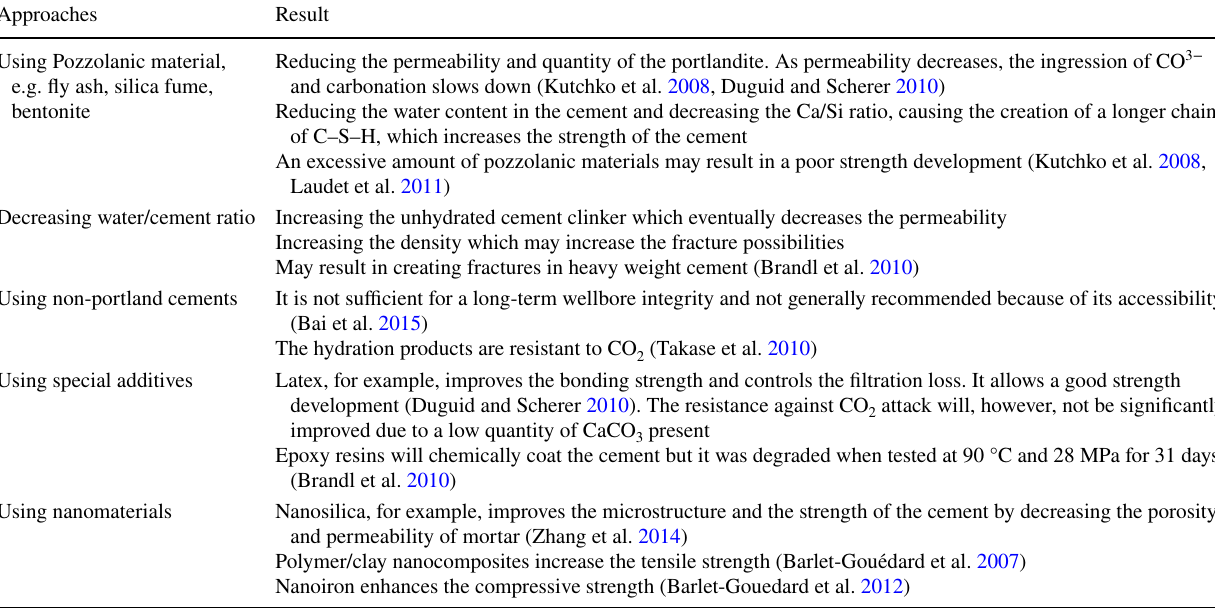
2 sequestration sites (modified after Abid et al. 2015)